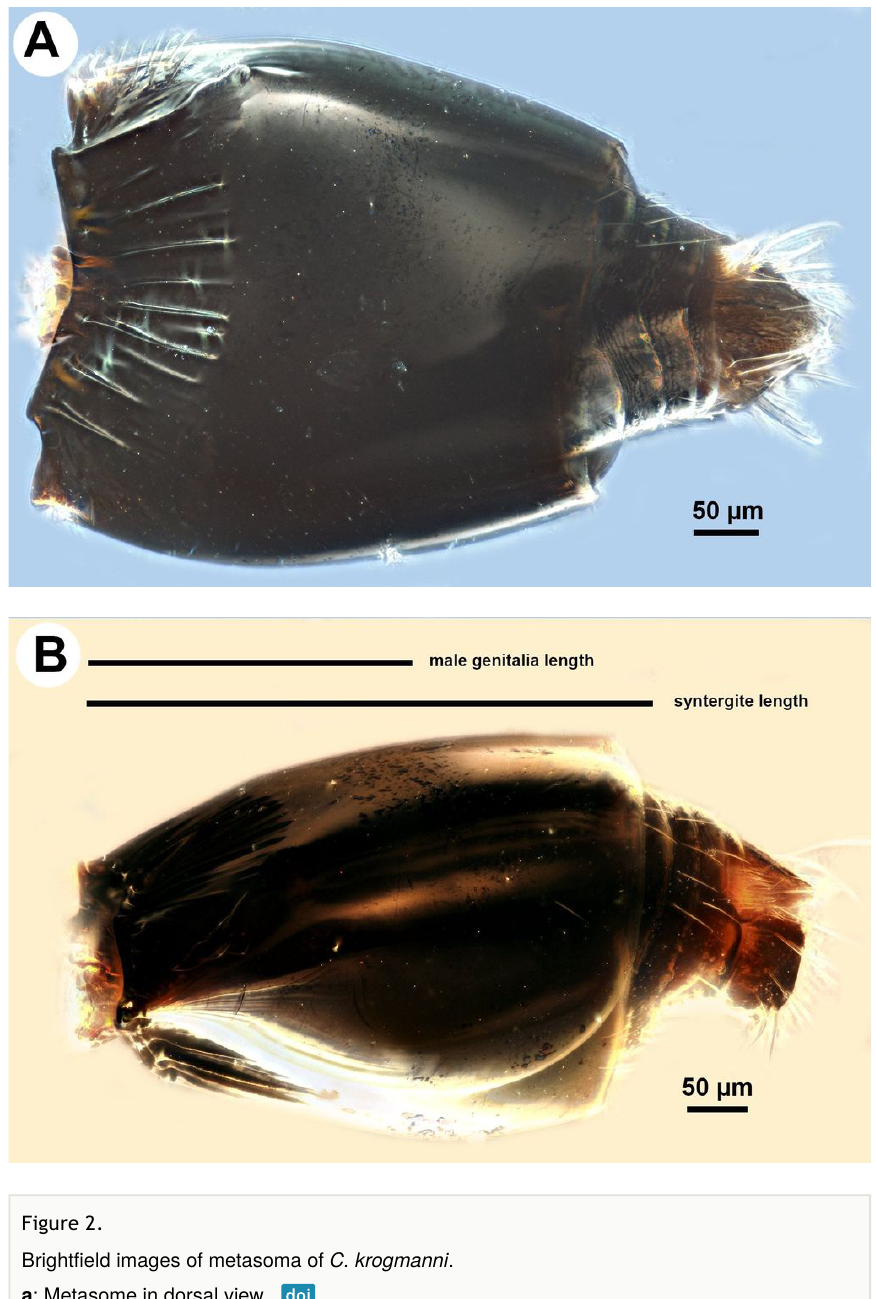
Figure 2. Bright fi eld images of metasoma of C. krogmanni . a : Metasome in dorsal view. b : Metasoma in lateral view showing length of genitalia in relation to